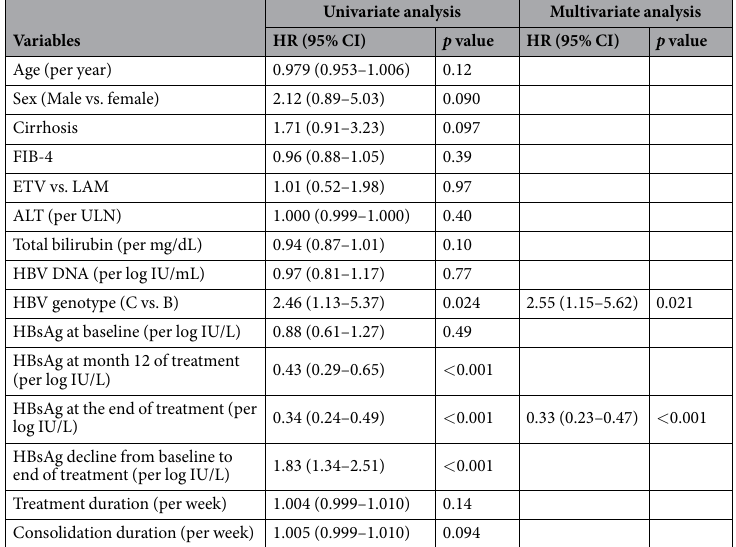
Table 3. Factors predictive of HBsAg loss. ALT: alanine aminotransferase, HR: hazard ratio, CI: confidence